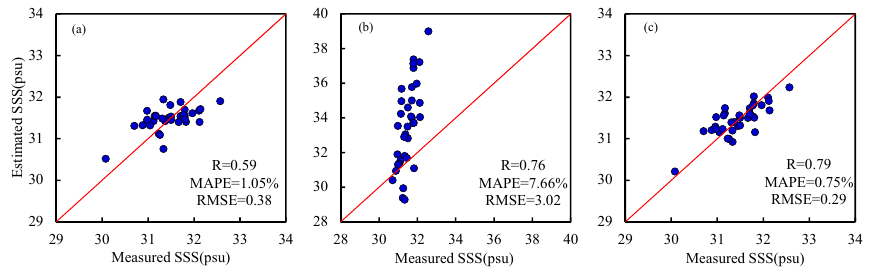
Figure 7. Comparison of the measured SSS versus the derived SSS between ( a ) the retuned model of Song et al., ( b ) the retuned model of Yu, and ( c ) the proposed model in this paper. The solid red line refers to the 1:1 line. Note that the R values are significant with p < 0.01.